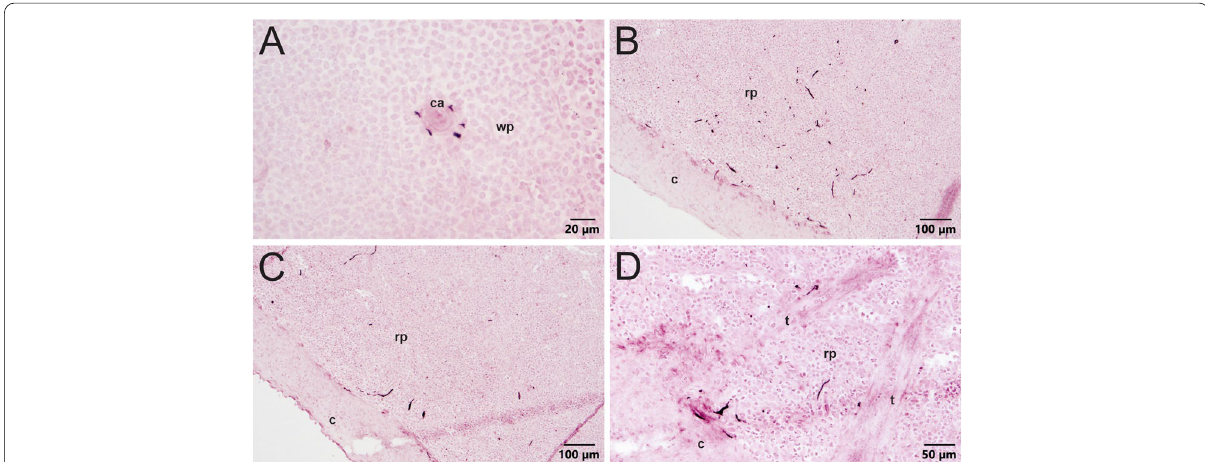
Fig. 4 TH staining of spleen section from donor 002 (VIP chromogen and citrate buffer antigen retrieval). A Sympathetic innervation of a central arteriole (ca.) cut in cross section. TH nerves extend further into the white pulp (wp) than observed in other donor spleens. B Sympathetic + innervation of the red pulp (rp) near the capsule (c) in the hilum region. Note the capsule has no innervation. C Fewer TH pulp of a sample from the pole region of the spleen. D A few sympathetic nerves run parallel to trabeculae (t) extending from the capsule into the red pulp